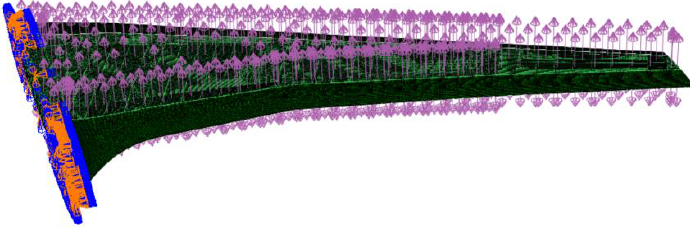
Figure 4. Boundary conditions and loading on the BWB wing model. Table 3. Values of pressure load at different values of factor of safety.